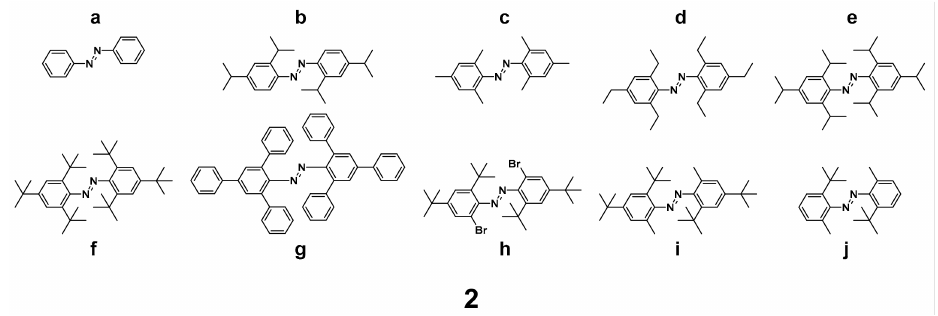
Figure 3. The molecule structures of a series of steric hindrance azobenzene derivatives 2a – 2j